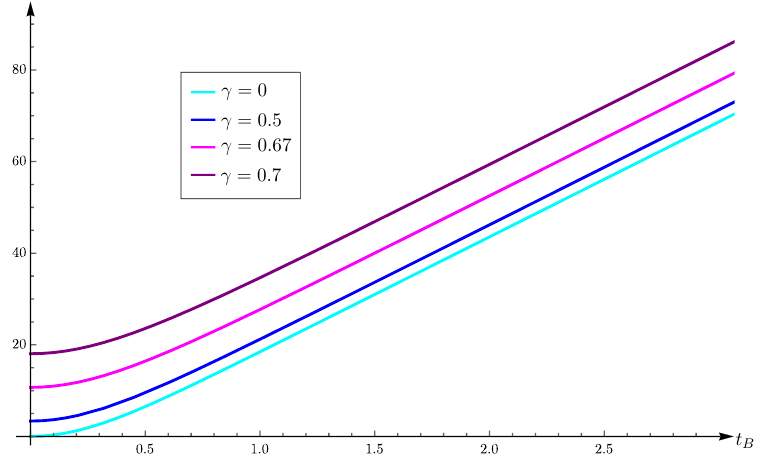
Figure 11 . Time dependence of the volume of the solutions depicted in figure 10 for different values of γ , with δ = 10 − 4 . The volumes V are renormalized after subtracting the divergence 4 π/δ . ren